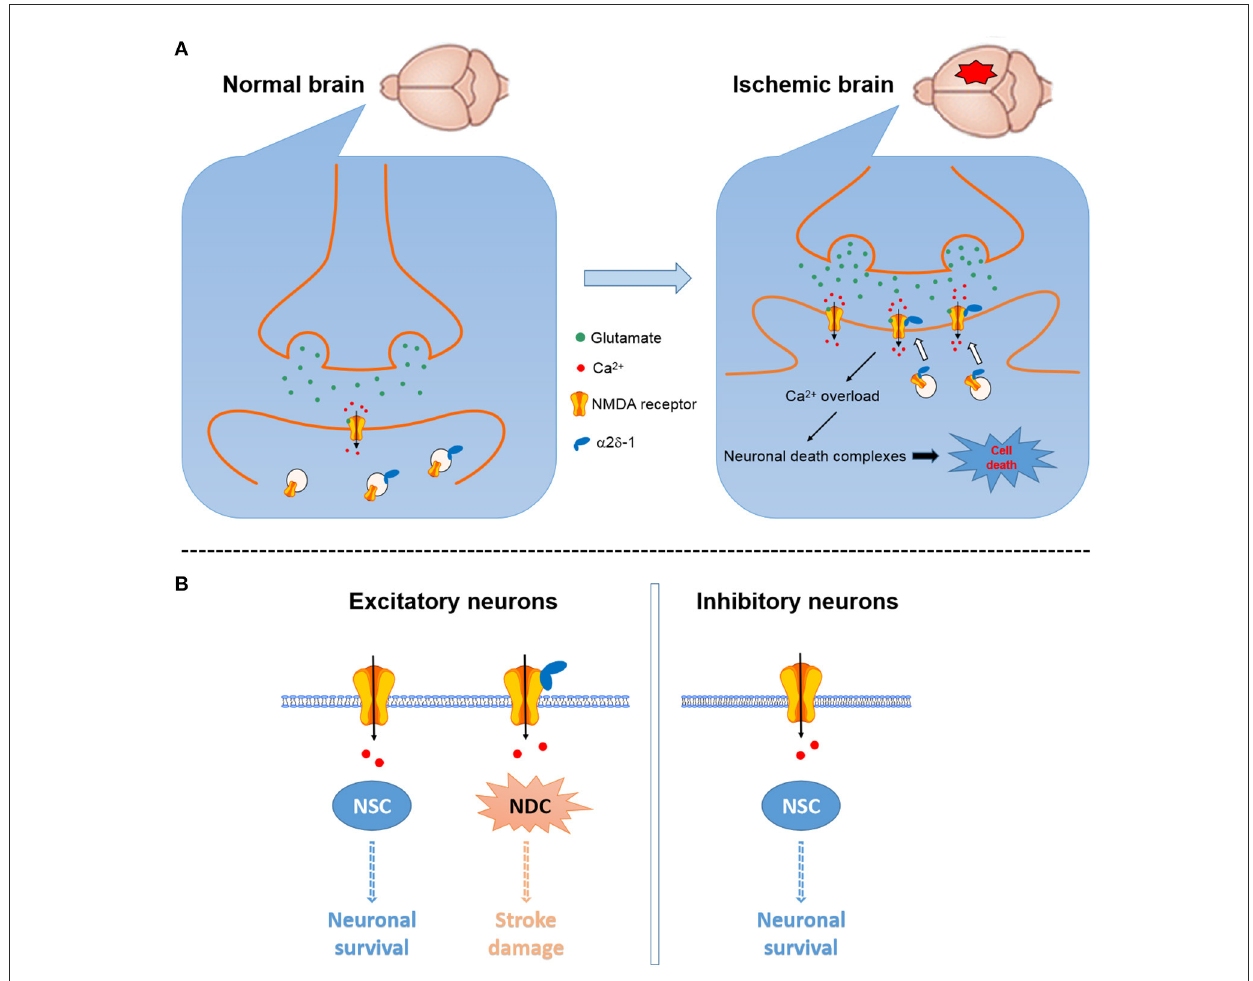
FIGURE2 Schematic showing the potential role of α 2 δ -1 in NMDAR-mediated excitotoxicity in cerebral ischemia and reperfusion. (A) Cerebral ischemia can increase α 2 δ -1 expression and α 2 δ -1-NMDAR interactions to promote the synaptic trafficking of α 2 δ -1-bound NMDARs, resulting in NMDAR hyperactivity, calcium overload, and downstream cell death-signaling pathways and eventually neuronal death and brain damage [ modified from Luo et al. (25)]. (B) α 2 δ -1-free NMDARs present in excitatory and inhibitory neurons likely mainly mediate the physiological functions of NMDARs via the neuronal survival-signaling complex (NSC), whereas α 2 δ -1-bound NMDARs expressed in excitatory neurons may predominantly activate the neuronal death-signaling complex (NDC).